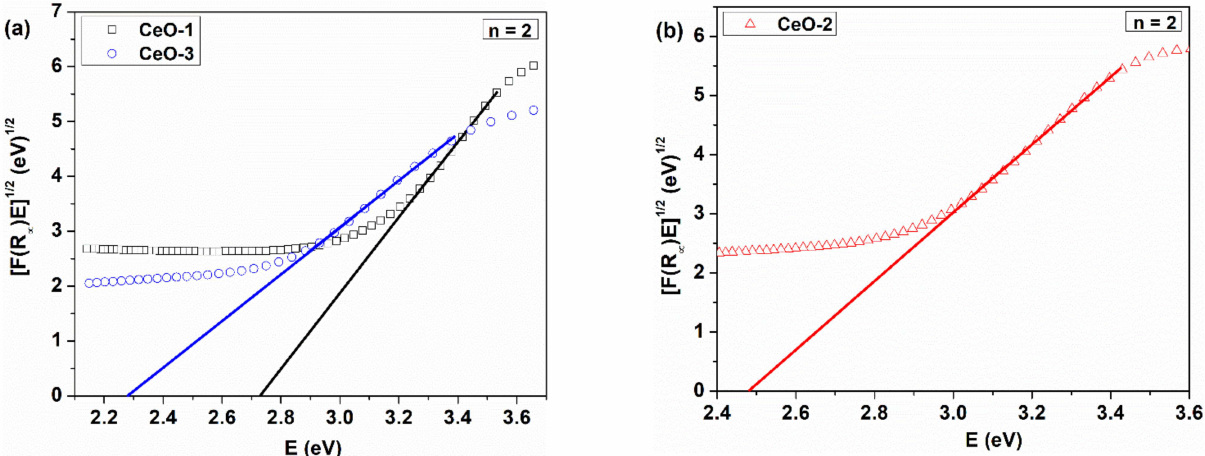
Figure 7. Tauc plots of [F(R)h ν ] 1/2 as a function of energy for cerium oxide nanoparticles: ( a ) CeO-1 and CeO-3, ( b )